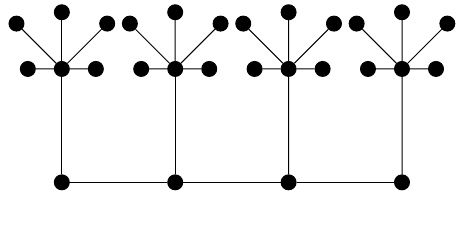
Fig. 3 The Firecracker graph F 4 , 7 .